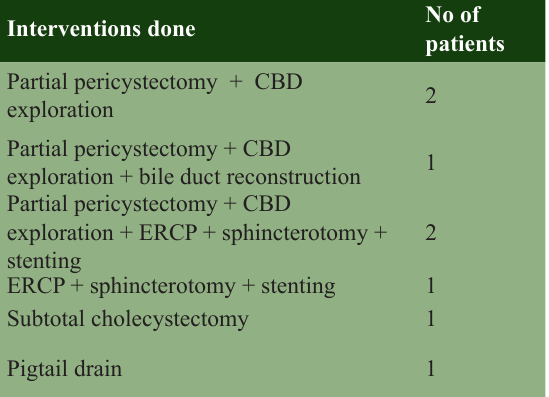
Table 1.Surgical procedure done for major CBC Interventions